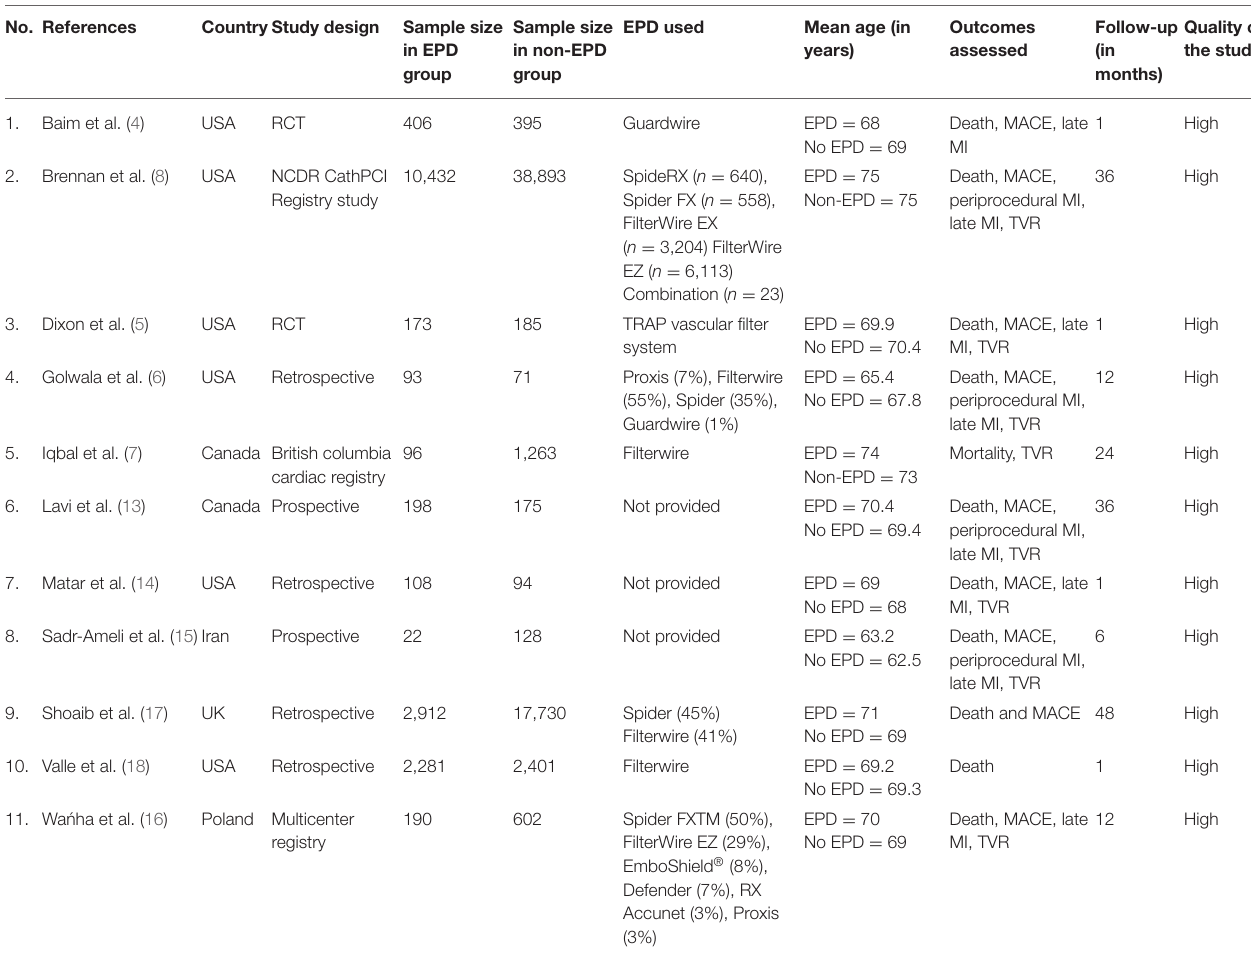
TABLE 1 | Characteristics of the included studies, N =